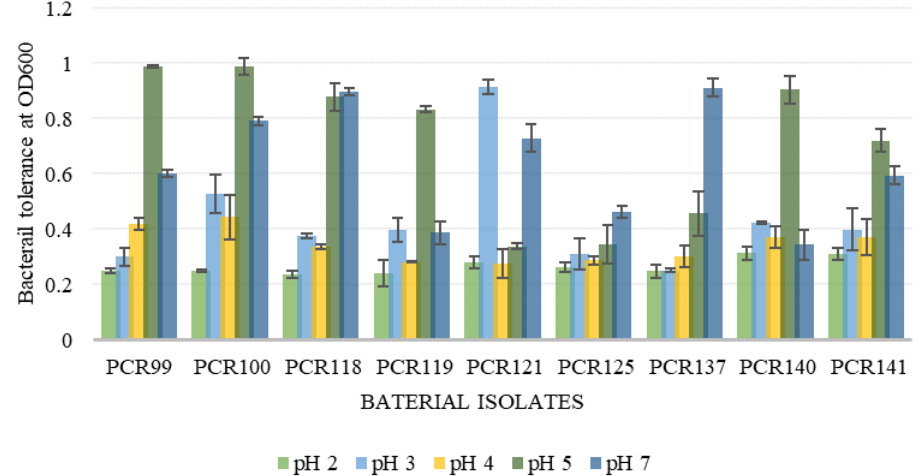
Figure 1. Detection of pH tolerance in bacterial strains. Values are means of replicate experiments; ± indicates standard deviation from the mean. Values differs significantly ( p < 0.05).